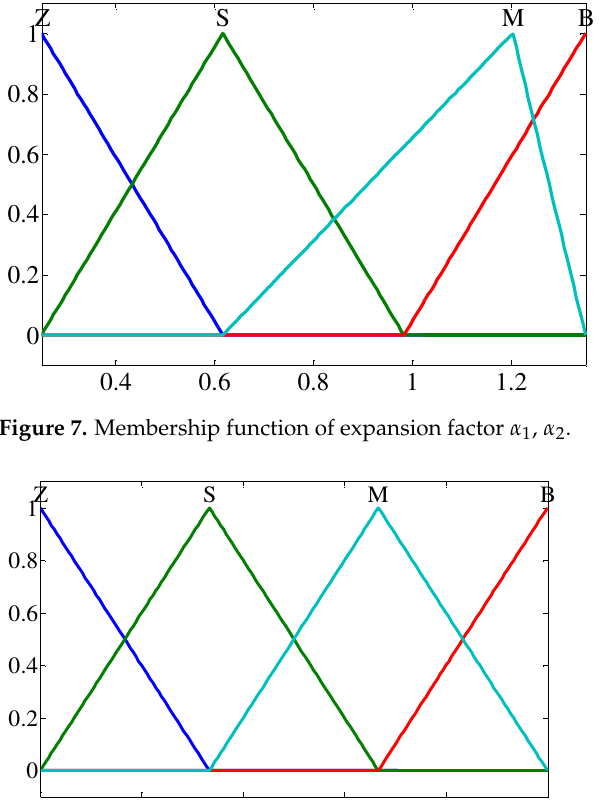
y(t) Figure 6. Schematic diagram of fuzzy PID control in variable theory domain. When designing the controller, the temperature rises from the ambient temperature of 25 °C to the ideal temperature of 70 °C, so the physical domain of temperature error is [−45, 45] °C. In this paper, if the initial fuzzy domain of error and error rate is [−6, 6], then